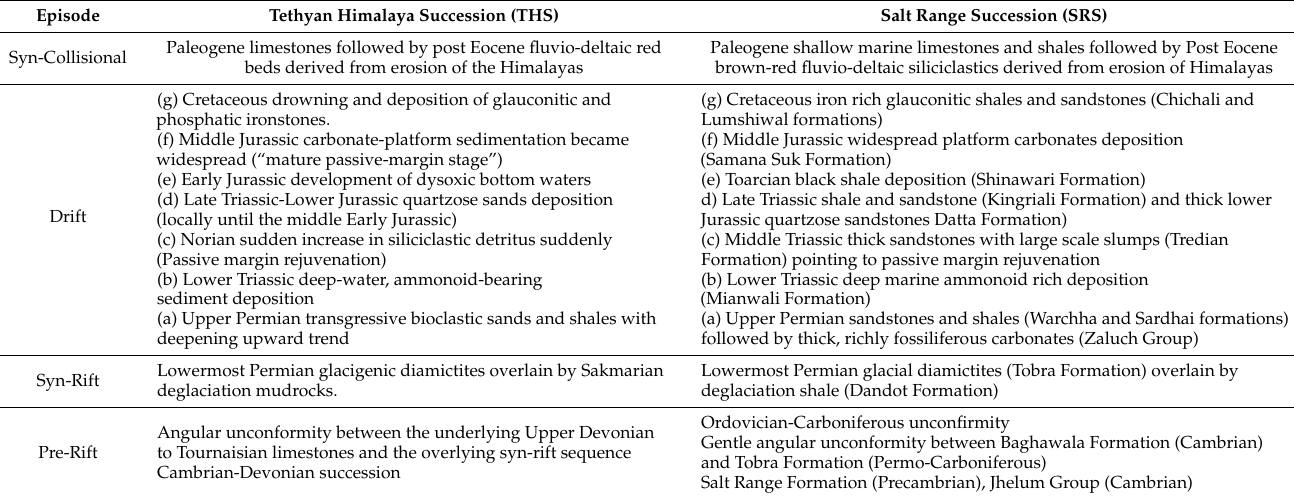
Table 1. Similarities between the Tethyan Himalaya Succession (THS) and Salt Range Succession (SRS) and their potential link to the Neo-Tethys tectonic events [16,20–24,37]. Episode Tethyan Himalaya Succession (THS) Salt Range Succession (SRS)